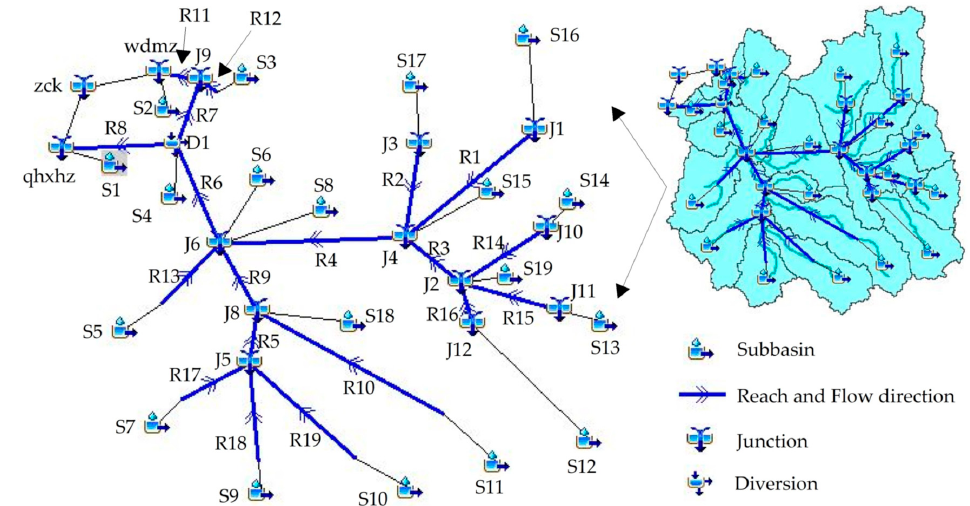
Figure 4. Sketch map of HEC ‐ HMS model for Qinhuai River basin. Four evaluation criteria (i.e., correlation coe ffi cient ( R ), Nash–Sutcli ff e e ffi ciency ( NSE ),